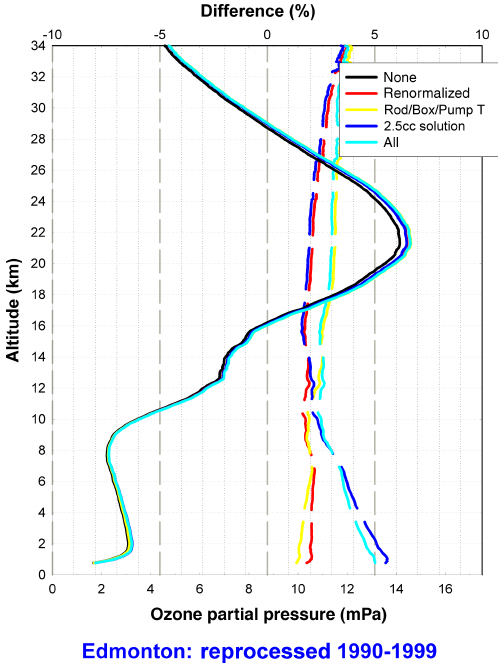
Figure 3. As Fig. 1 but for the 1990s. “Rod/Box/Pump T” shows the average change introduced by the corrections to the tempera- ture measured by the different thermistors used during this decade (Sect. 2.6).